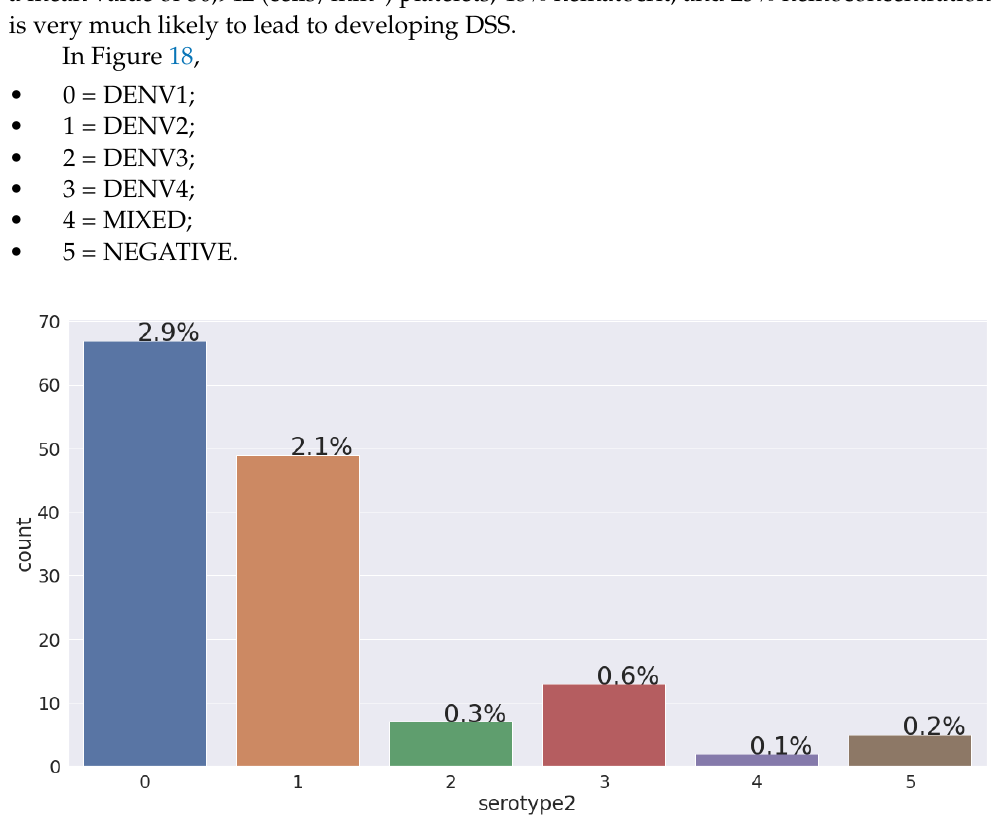
Figure 18. Percentage of serotype2 of patients going into